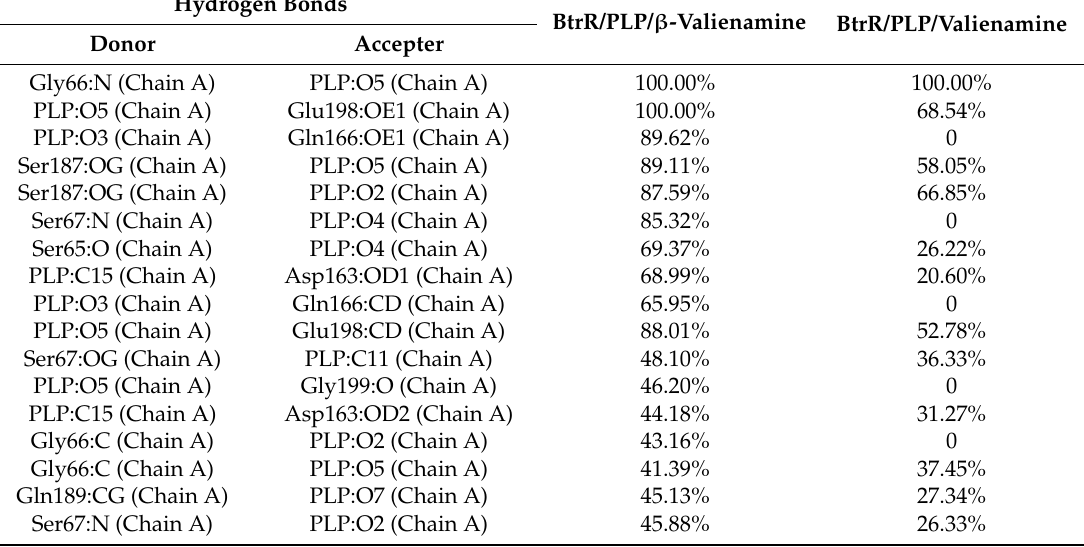
Table 2. Hydrogen bond occupancies between BtrR and PLP for BtrR/PLP/ β -valienamine and BtrR/PLP/valienamine during MD